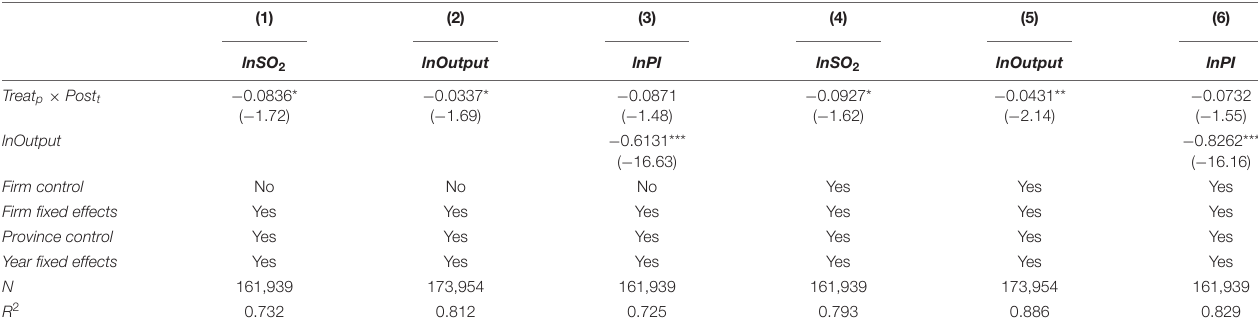
TABLE 3 | Policy effects of emission fee increases.